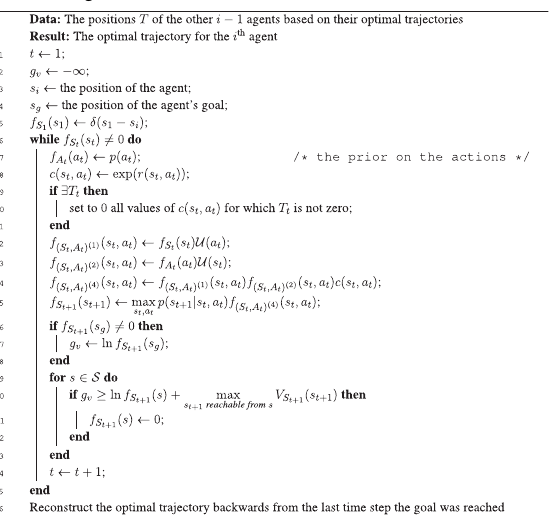
Algorithm 2. Algorithm for the forward propagation in a MAS context using the V-functions